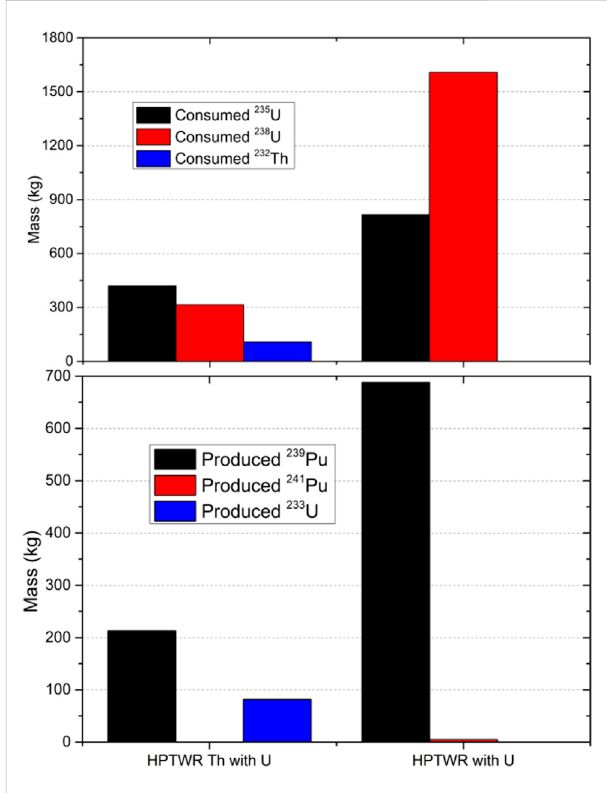
FIGURE 15 Consumed nuclear fuel amounts and produced fi ssile nuclide amounts in the HPTWR with two fuel loading